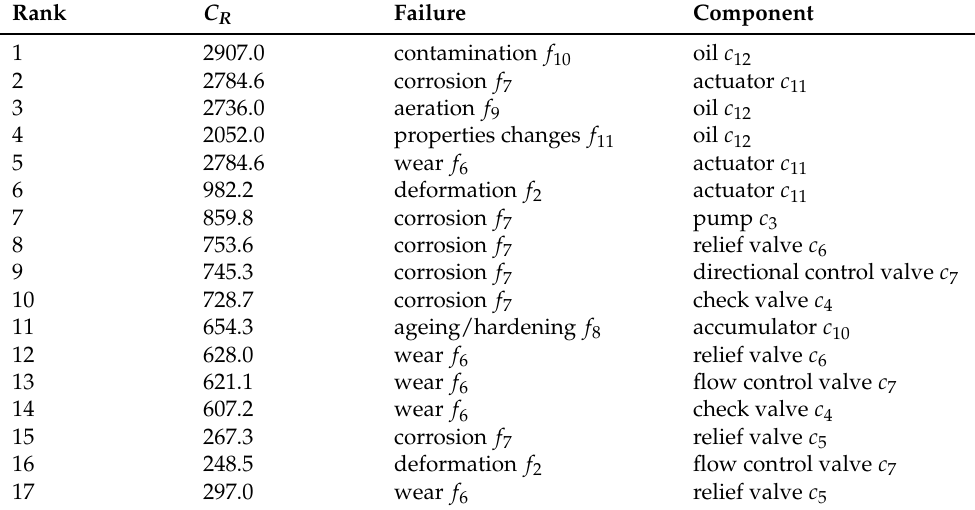
Table 5. Functional failures f f 2 . Criticality.